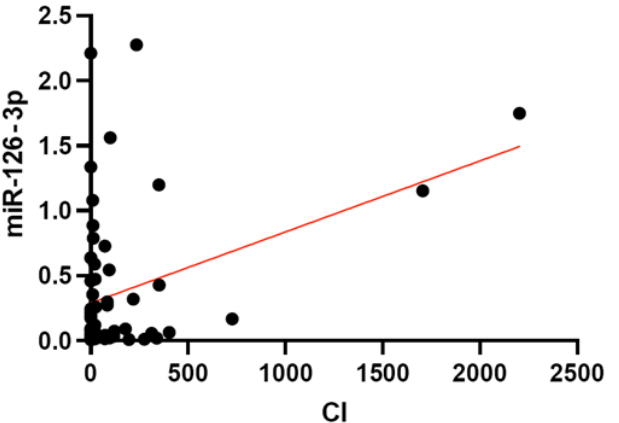
Figure 5. Relationship of miR ‐ 126 ‐ 3p relative plasma levels in patients with different values of coronary calcification according to the Agatson scale (CI) . coronary calcification according to the Agatson scale